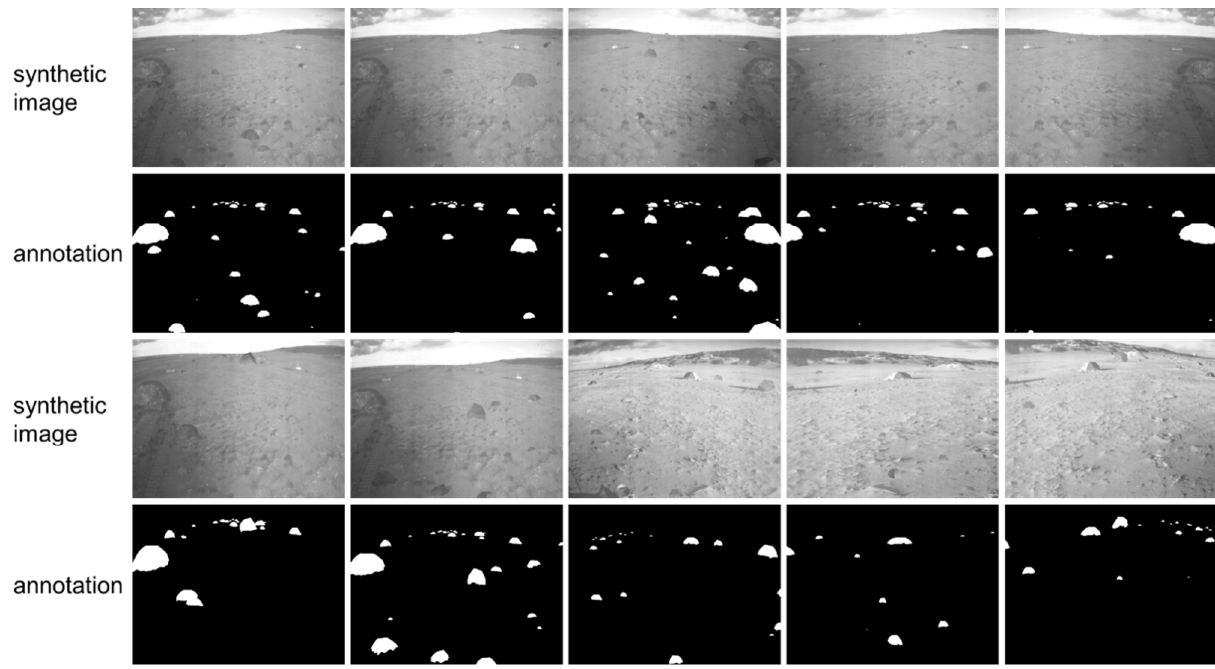
Figure A2. Some examples from the synthetic dataset. “Synthetic image” and “annotation” refer to the synthetic images and corresponding annotations, respectively. Annotations use white and black pixels to represent the rock and background pixels.